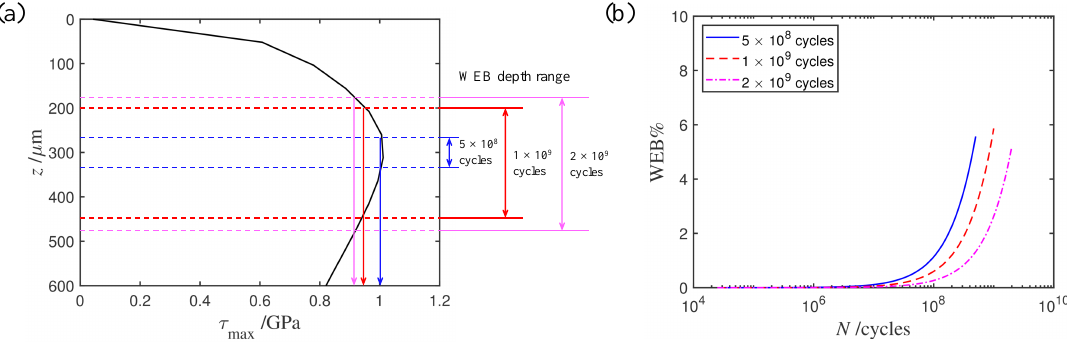
Figure 9. WEB appearance analysis. ( a ) Critical stress for WEB appearance in the samples indexed by the boundaries of WEB formation region. ( b ) Calculated development extent of WEBs located at the boundaries of WEB formation